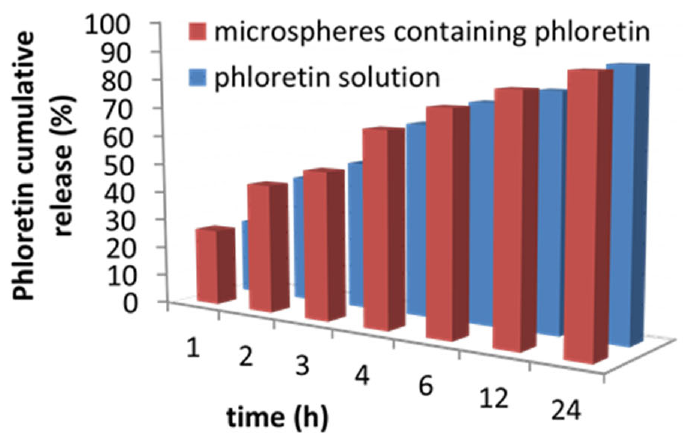
Figure 5. Graph of the cumulative release of phloretin. The results represent the mean ± SD of three separate experiments. Significance was evaluated by the unpaired t